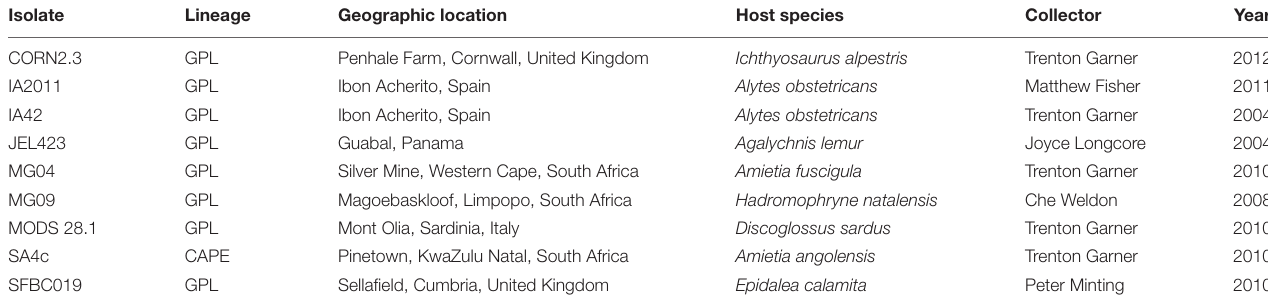
TABLE 1 | Batrachochytrium dendrobatidis ( Bd ) strain information for nine isolates used in this study, comprising eight isolates of BdGPL, and one of BdCAPE. Isolate